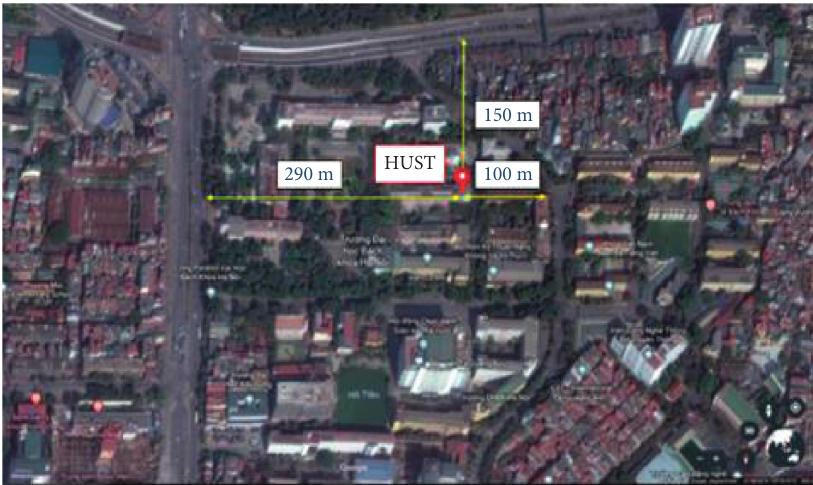
Figure 1: Sampling site of particulate matters for PAHs